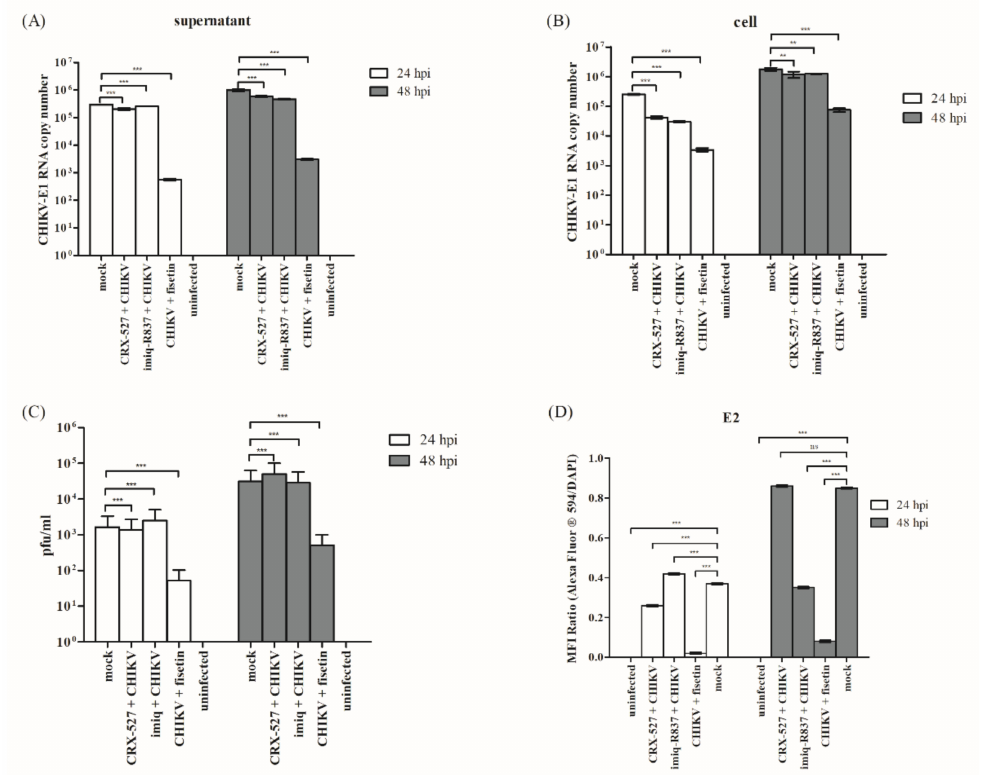
Figure 1. CHIKV inhibitory potential of fisetin and the TLR agonists. Viral yield reduction data from ( A ) assay supernatants; ( B ) cell lysates; ( C ) plaque count (pfu/mL) obtained from mock, agonist- treated, and fisetin-treated Huh7 cells (dilution 1:10); and ( D ) the mean fluorescence intensity (MFI) ratio of CHIKV-E2 protein in relation to DAPI. CHIKV infection was performed using MOI = 1. Data are representative of three independent experiments and values are expressed as mean ± SD. One-way ANOVA ( p < 0.0001) and Dunnett’s multiple comparison post-test (** is p < 0.01 and *** is p < 0.001)) were performed by setting mock Huh7 cells of respective time points as an independent